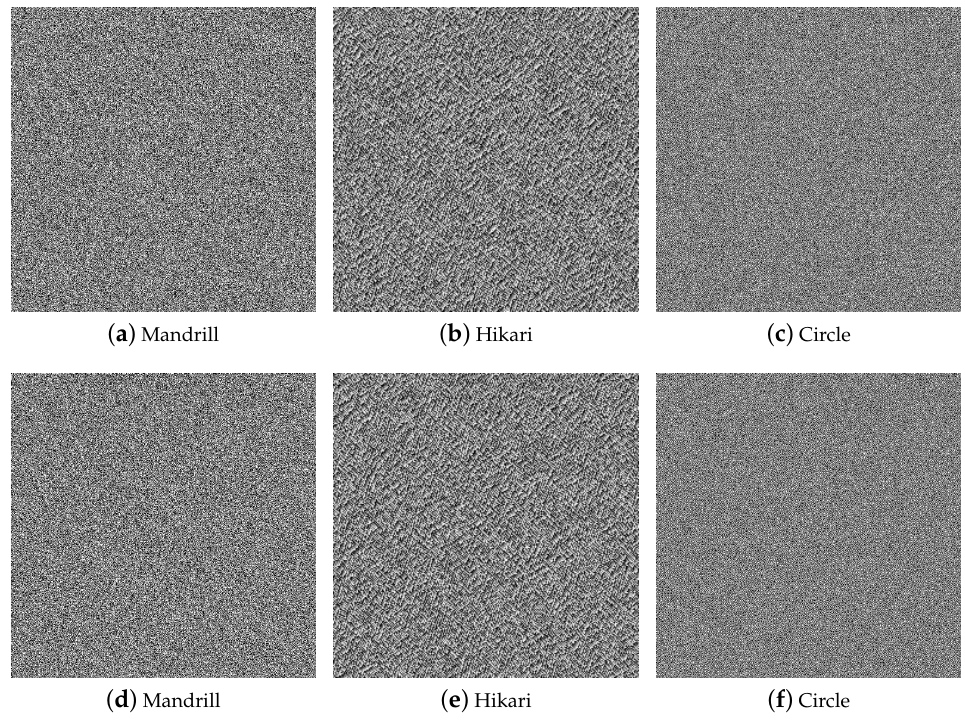
Figure 11. Optimized phase distributions by proposed algorithm and GS algorithm used for experiments: ( a – c ) were produced by proposed algorithm, ( d – f ) were produced by GS algorithm. ( a , d ) are “mandrill”, ( b , e ) are “hikari”, ( d , f ) are “circle”.